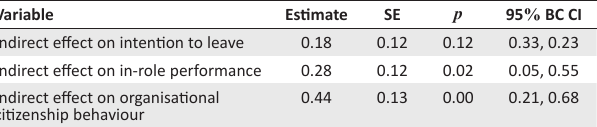
FIGURE 1: The structural model – Standardised solution with standard errors in parentheses. TABLE 5: Indirect effect of person–environment fit on intention to leave, in-role performance and organisational citizenship behaviour via workplace flourishing. Variable Estimate SE 95 % BC CI Indirect effect on intention to leave